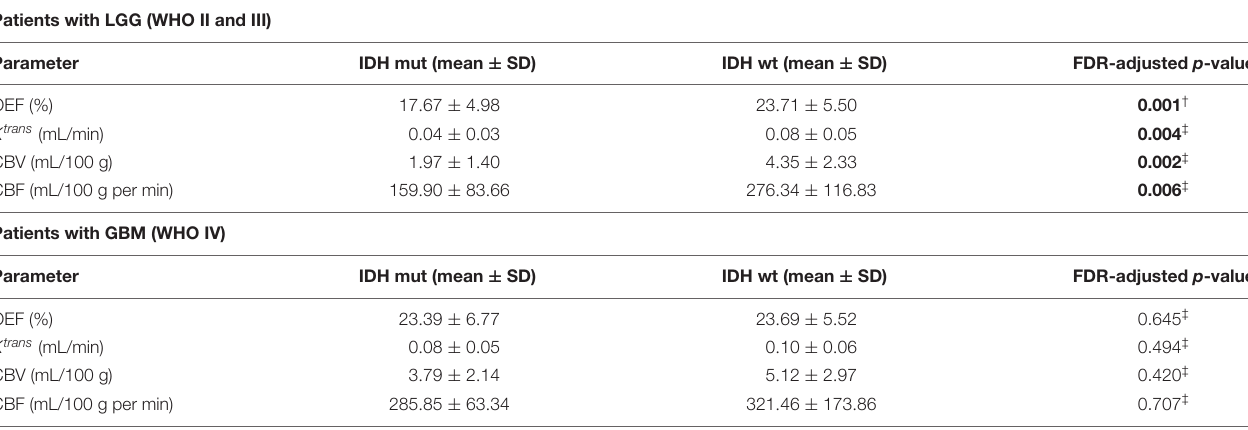
FIGURE 3 | Quantitative comparison of oxygen metabolism and vascular metrics of genetic profiles. (A–D) Comparison of OEF, K trans , CBV, and CBF measurements between IDH1 mutant and wild type in lower-grade glioma (left panel), as well as between MGMT methylated and unmethylated glioblastoma (right panel). Comparison of OEF (E) and CBV (F) values between RTK and non-RTK subgroup. The violin plot marked with asterisk (*) indicates that the values were significantly different between the groups (* P < 0.05; ** P < 0.01). TABLE 2 | Comparison of biomarkers for subgroups of IDH mutation